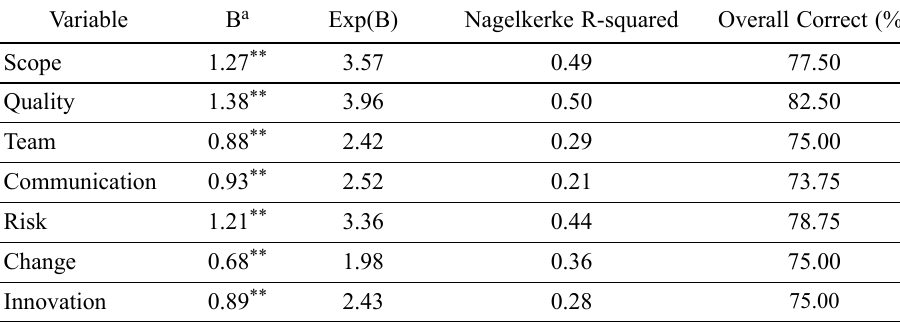
Table 3. Univariate logistic analysis